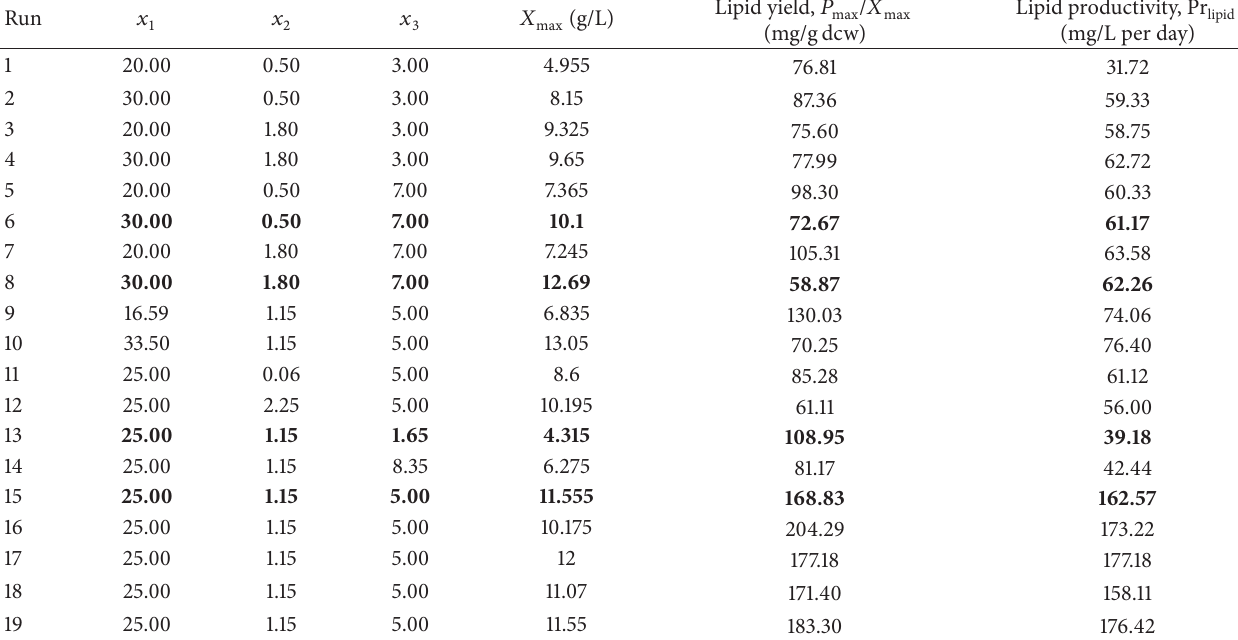
Table 2: Central composite design (CCD) used in RSM and ANN studies showing the actual levels and observed responses during the mixotrophic cultivation Tetraselmis sp. FTC